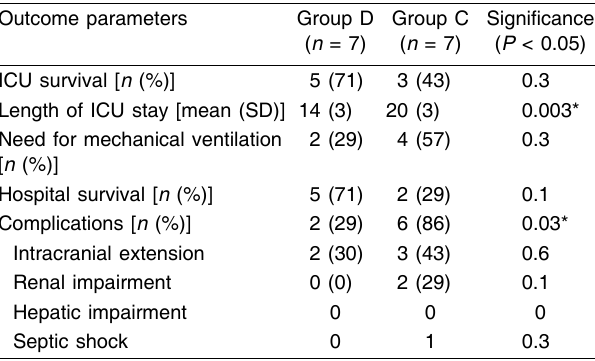
Table 5 Outcome parameters Outcome